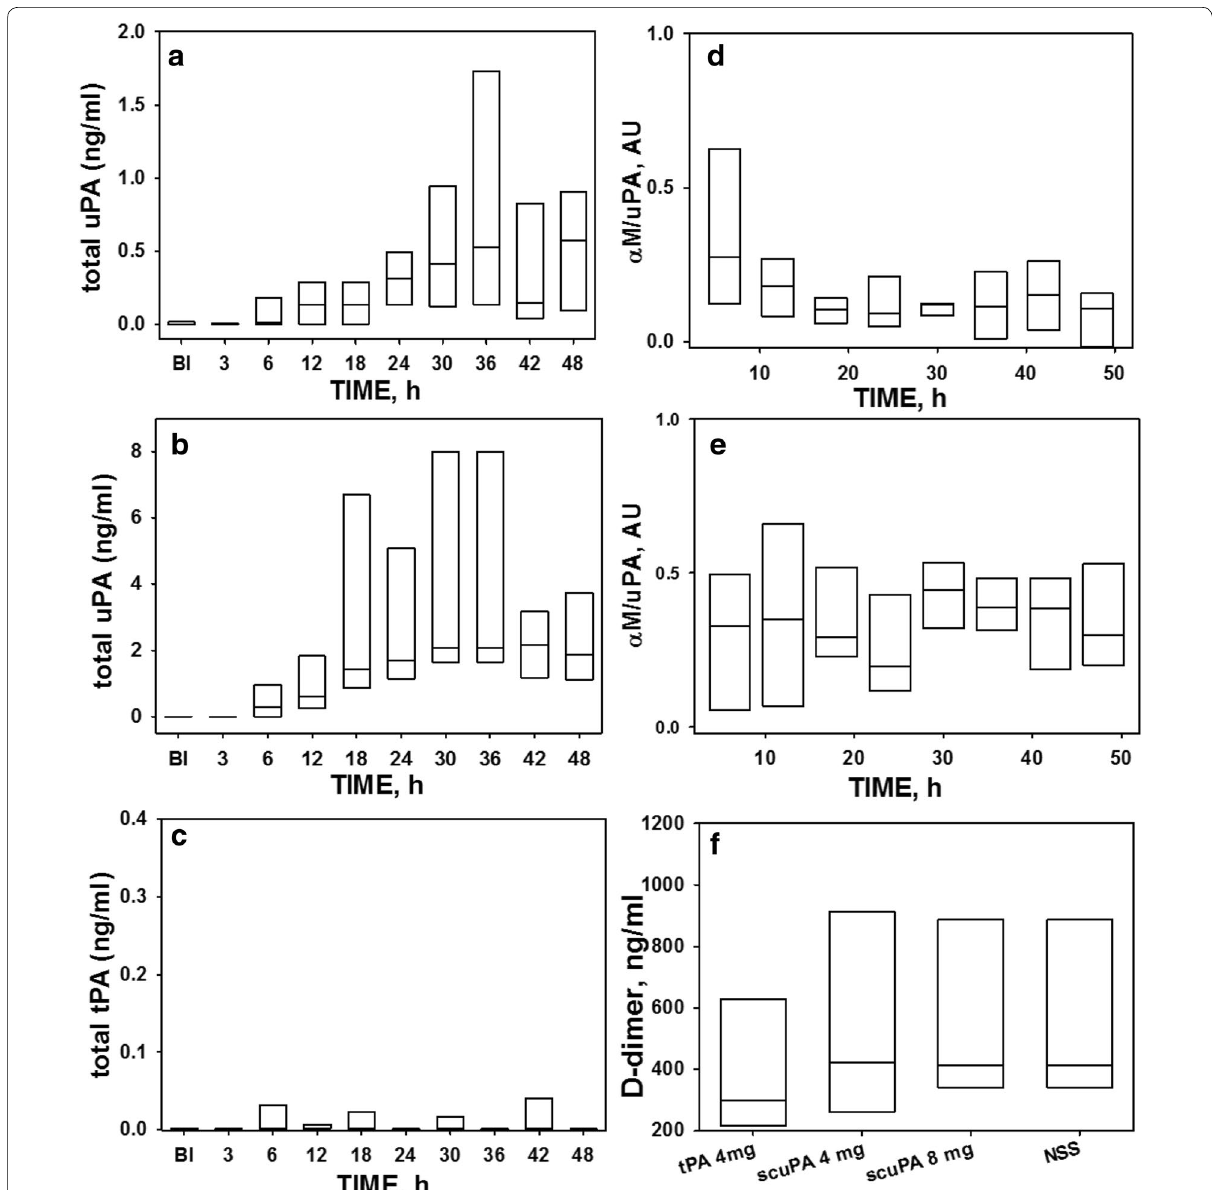
Fig. 9 Effect of nebulized scuPA and tPA treatments on detection of the plasminogen activators, αM/uPA complexes and d -dimers in plasma. The data shown were obtained from all animals in Group 2 and illustrated in a box plots (showing median with interquartile range). Temporal changes in the levels of uPA antigen ( a , b ) and “molecular cage” type αM/uPA complexes ( d , e ) in plasma of animals treated with 4 and 8 mg scuPA are illustrated, respectively. Levels of uPA antigen ( a , b ) in plasma of animals treated with 4 and 8 mg scuPA increase significantly over time (p < 0.001). Difference were more profound with higher levels for animals treated with scuPA at 8 mg compared with those treated with tPA ( c ) or scuPA ( a ) at 4 mg at each time point where samples were collected, while levels for the scuPA at 4 mg were not significantly different from those for tPA ( c ). There was no statistical significant difference between plasma levels of d -dimers ( f ), indicating comparable systemic fibrinolysis in all treatment groups. c Illustrates relatively low total tPA antigen levels including all animals from the Group2 4 mg (n 5) subgroups. Data are presented as box = plots (showing interquartile ranges). The concentrations of antigens were determined by ELISA assays designed to detect the human antigens (Molecular Innovations, Inc., MI). Levels of αM/uPA complexes were assessed by uPA amidolytic activity in the plasma in the presence of 100 nM human recombinant PAI-1, as described [24]. The concentration of d -dimer in plasma of ISIALI sheep ( f ) after vehicle, tPA or scuPA nebulized treatment was measured using sheep d -dimer (D2D) ELISA Kit (MyBioSource, CA) as described in